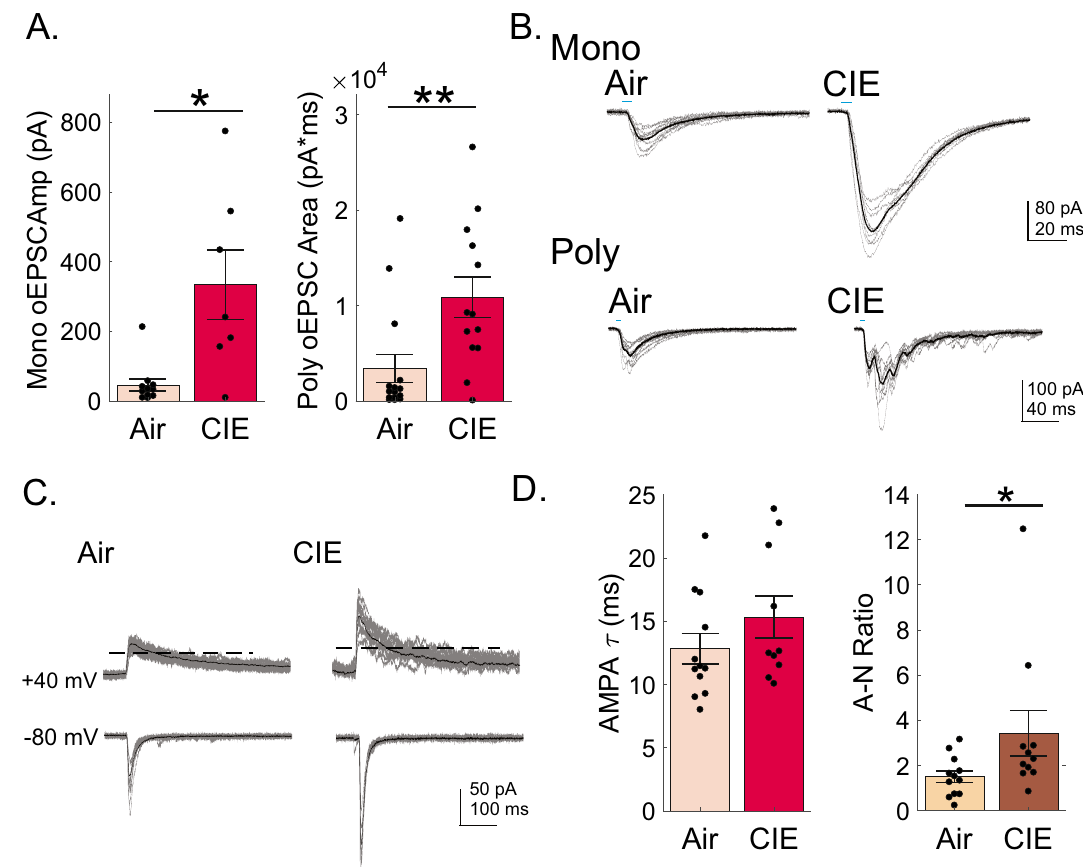
Figure 4. AMPA-mediated oEPSCs and AMPA/NMDA ratios are increased in vSub neurons of CIE rats. ( A ) Evoked monosynaptic amplitudes (left graph) and polysynaptic areas (right graph) of AMPA-mediated oEPSCs of vSub neurons in the presence of PTX are increased in vSub neurons of CIE rats. ( B ) Representative traces of monosynaptic (upper traces) and polysynaptic (lower traces) AMPA-mediated oEPSCs shown in ( A ) of Air (left column) and CIE (right column) rats. ( C ) oEPSCs recorded in the presence of PTX at − 80 mV (lower traces) to isolate AMPA-mediated EPSC amplitude and at + 40 mV (upper traces) to establish the NMDA-mediated amplitude within the same vSub neuron. ( D ) CIE rats have an increased AMPA/NMDA ratio (right graph) in CIE rats that cannot be explained by a change in AMPA tau (left graph). In representative traces, individual inputs are shown by thin lines while the average response amplitude is illustrated by a thicker overlaid line. Blue bars above figures illustrate onset and duration of optical stimulation. *p < 0.05 and ** p < 0.01 and errors are reported as ±